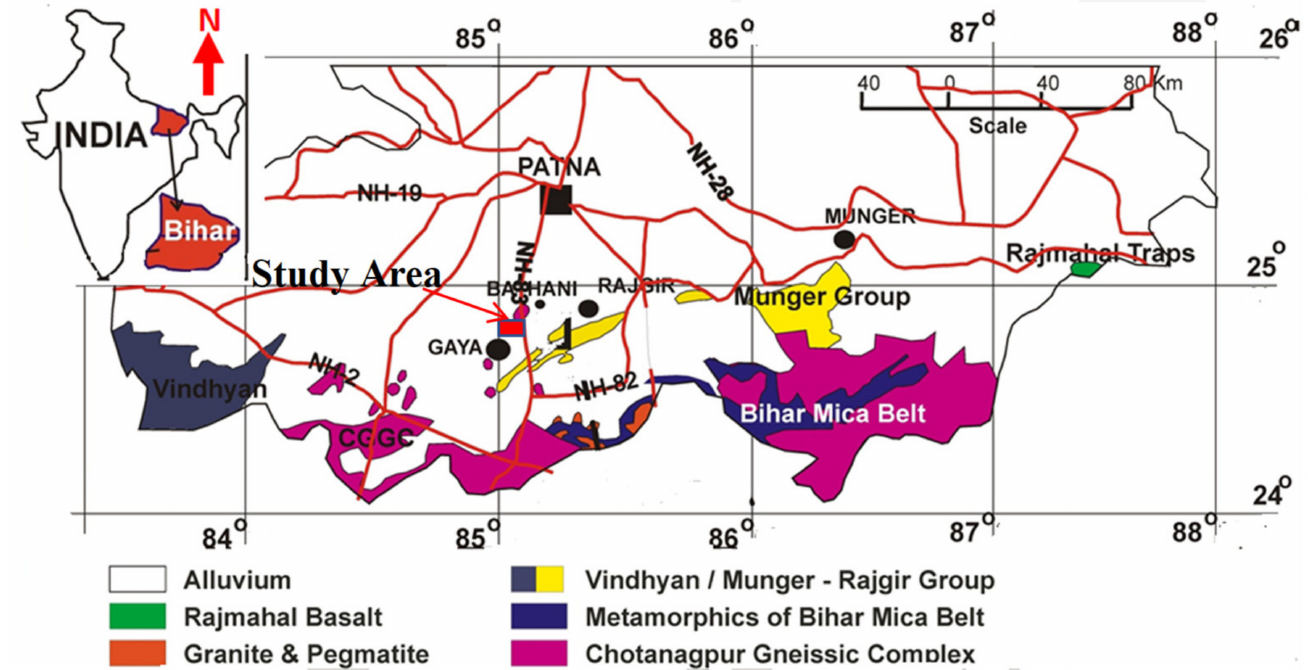
Figure 1. The regional geological map of Bihar, India, and the location of the study area (marked out as a red colour-filled rectangle) (Mukhopadhyay et al.,